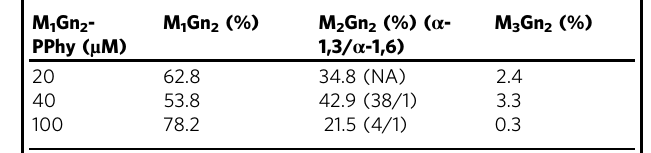
Table 3 Relative percentage of oligosaccharides in hAlg2 reactions with 20 μ M of M 1 Gn 2 -PPhy substrate.